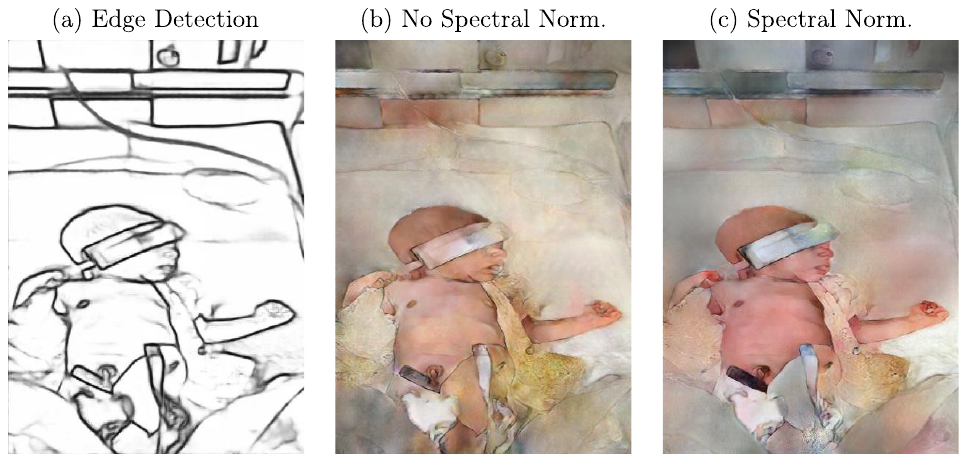
Figure 4. ( a ) Example edge detection image and qualitative effect of a training ( b ) without and ( c ) with spectral normalization on generated images.